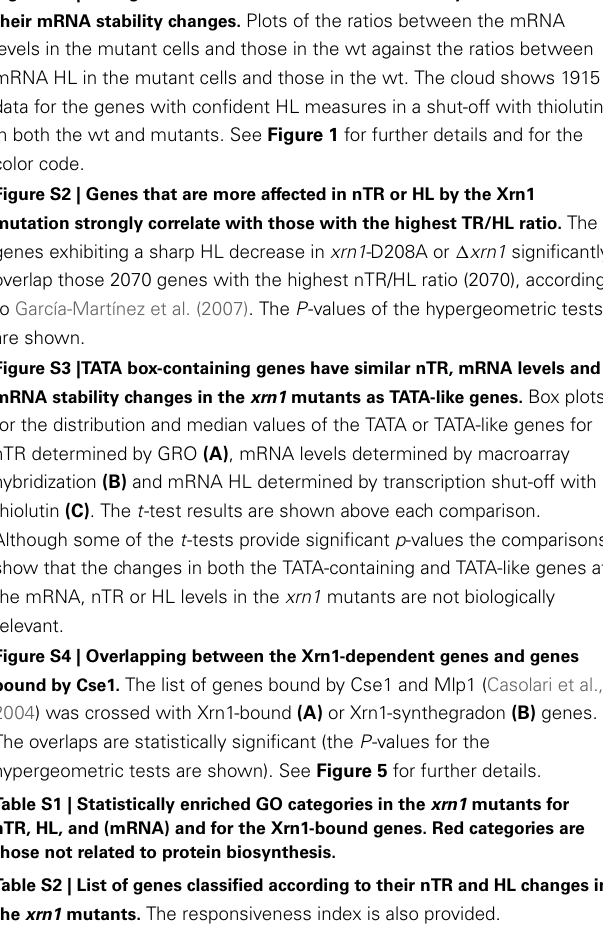
those not related to protein biosynthesis.